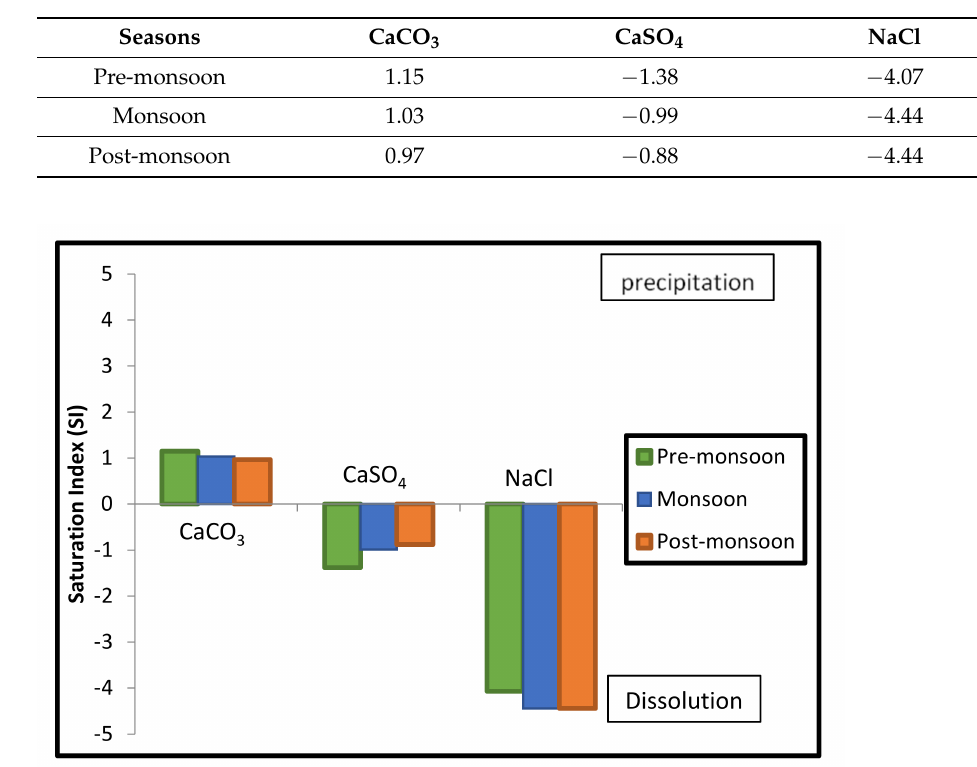
Figure 5. Season-wise trend of Saturation Index (SI) with respect to CaCO 3 , CaSO 4 and NaCl in the groundwater of Mewat, Haryana,